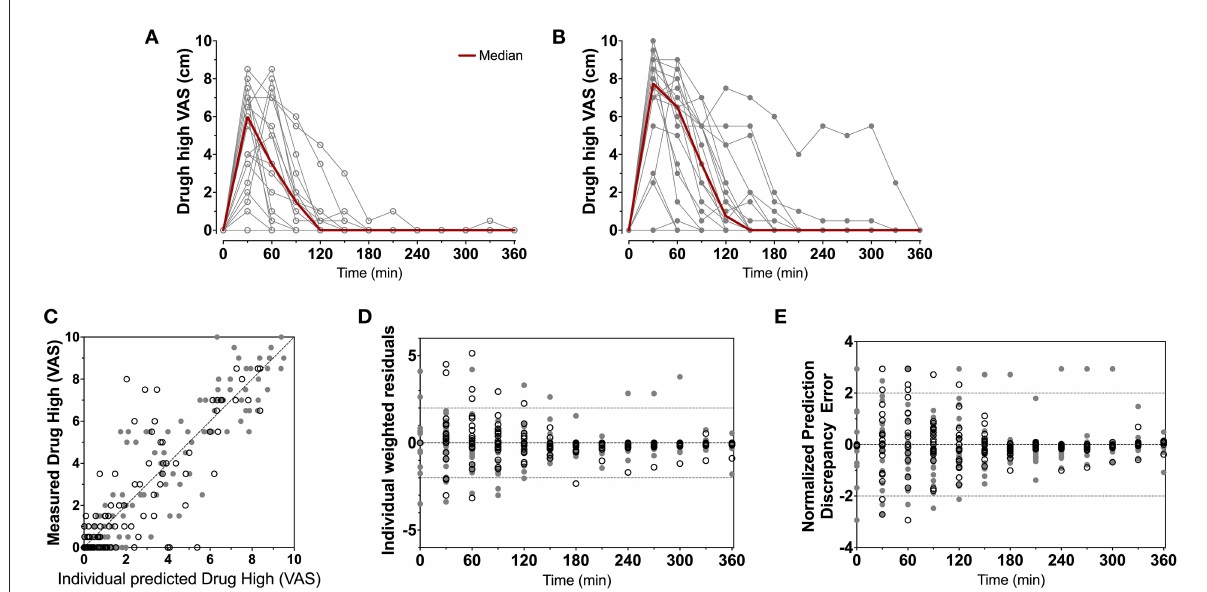
FIGURE4 Drug high data. Individual and median drug high visual analog scores following the 50mg (A) and 100mg (B) S- ketamine oral thin film. (C–E) Goodness-of-fit plots, (C) measured vs. individual; (D) individual weighted residuals vs. time; (E) normalized prediction discrepancy errors vs. time. Dashed lines are the 95% confidence intervals. Open circles denote data from the 50mg S- ketamine oral thin film and closed circles data from the 100mg S- ketamine oral thin